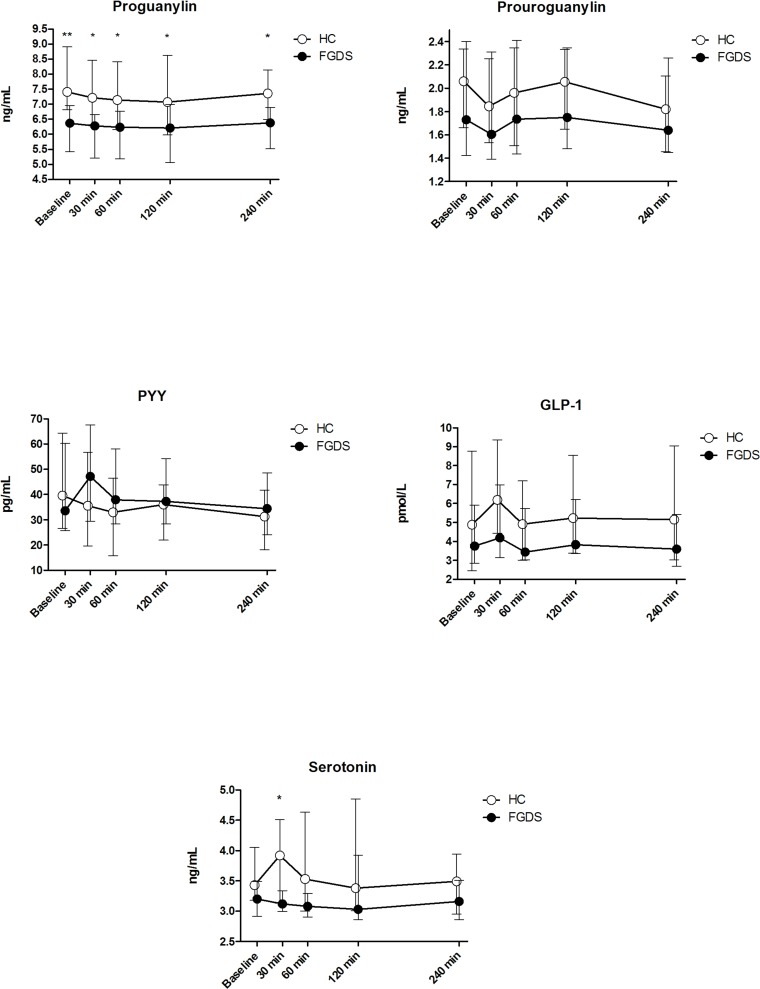
Gastrointestinal hormones.Median plots with IQR (25 and 75 percentiles) for the time course secretion of the different hormones before (baseline) and after a meal. Significant differences were found between FGDS and HC regarding plasma Proguanylin at all time points (baseline, 30 min, 60 min, 120 min and 240 min) and for plasma Serotonin 30 min postprandial (* p< 0.05,**p < 0.01). There were no significant differences in plasma measurements of GLP-1, PYY and Proguanylin between FGDS and HC.